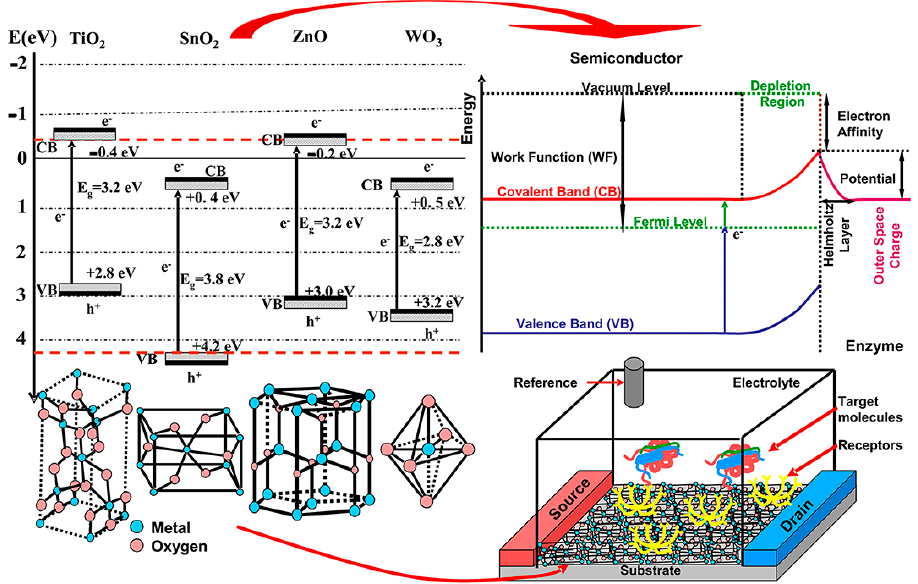
Figure 11. Working scheme of a Field Effect Transistor (FET) type of sensor based on MOX showing band energies, crystalline structure and biosensor configuration. Figure reused under the terms of CC-BY license from Ref. [12].